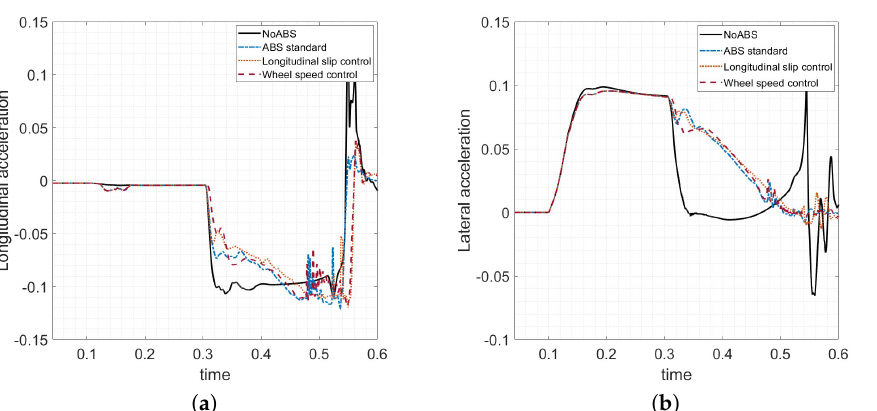
Figure 11. Longitudinal ( a ) and lateral ( b ) vehicle acceleration in combined braking from 80 to 0 km/h at lateral acceleration of 0.9 g with and without ABS .